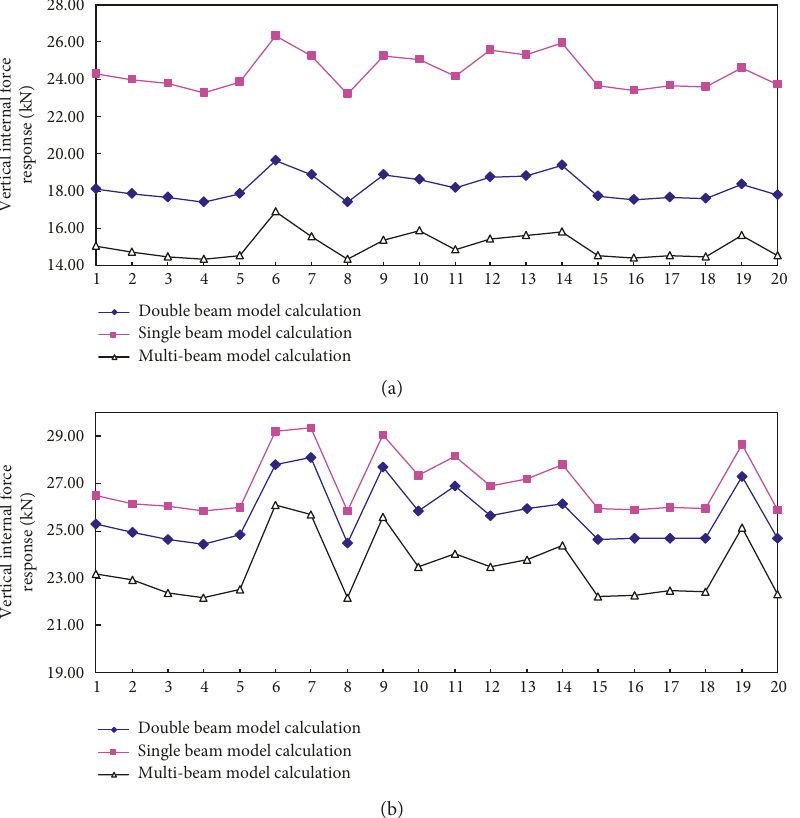
Double beam model calculation Single beam model